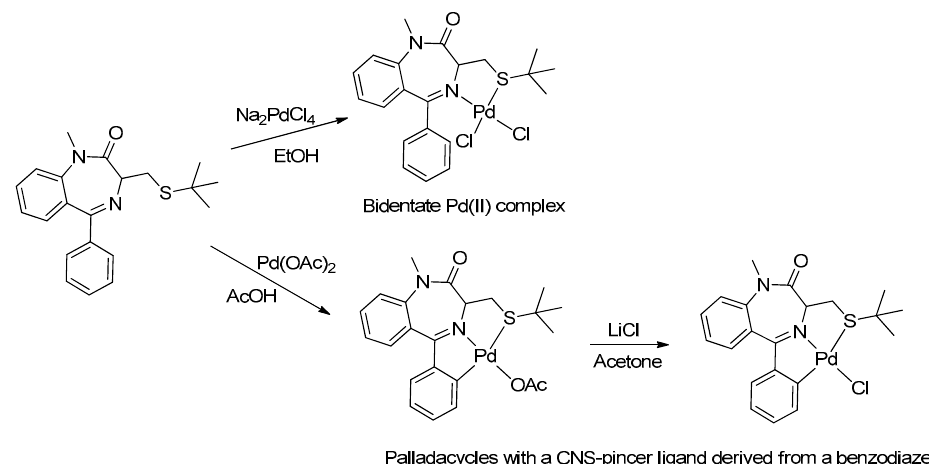
Figure 9. First example of a metallacycle in which the benzodiazepine derivative acts as a pincer ligand.